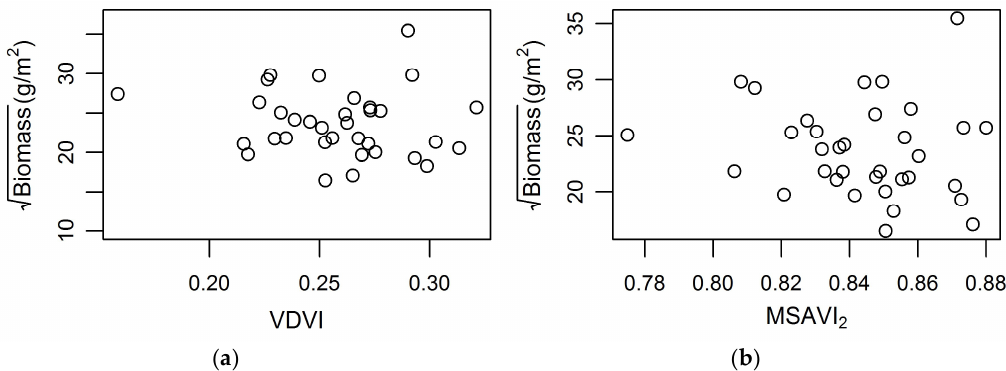
Figure 6. Square-root biomass g/m 2 plotted against vegetation indexes within PIE. ( a ) Visible differences vegetation index (VDVI); ( b ) modified soil vegetation index 2 (MSAVI 2 ).